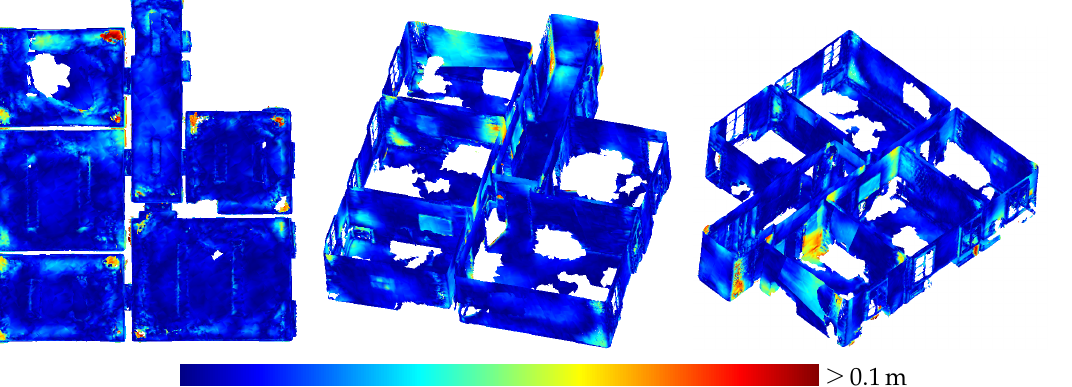
Figure 18. Accuracy of the HoloLens triangle mesh evaluated against the TLS ground truth. The scale factor was determined to 0.9938 by registration. The mean distance to the ground truth amounts to 1.7cm.